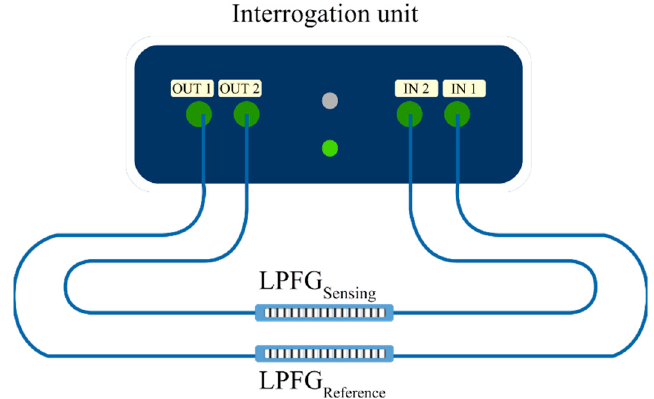
Figure 3. Sensing scheme with one LPFG acting as a reference sensor providing compensation to the second sensor.